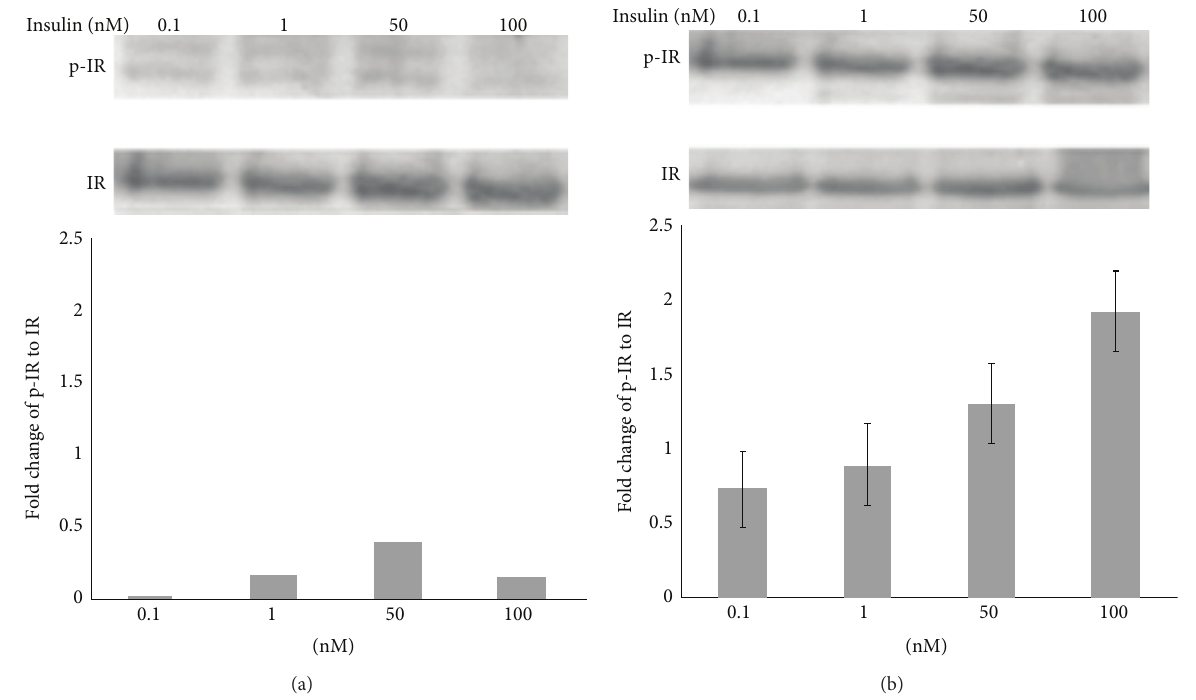
Figure 3: Selective insulin-induced phosphorylation of IRS-1 in Δ IGF-1R PC-12 cells (a,